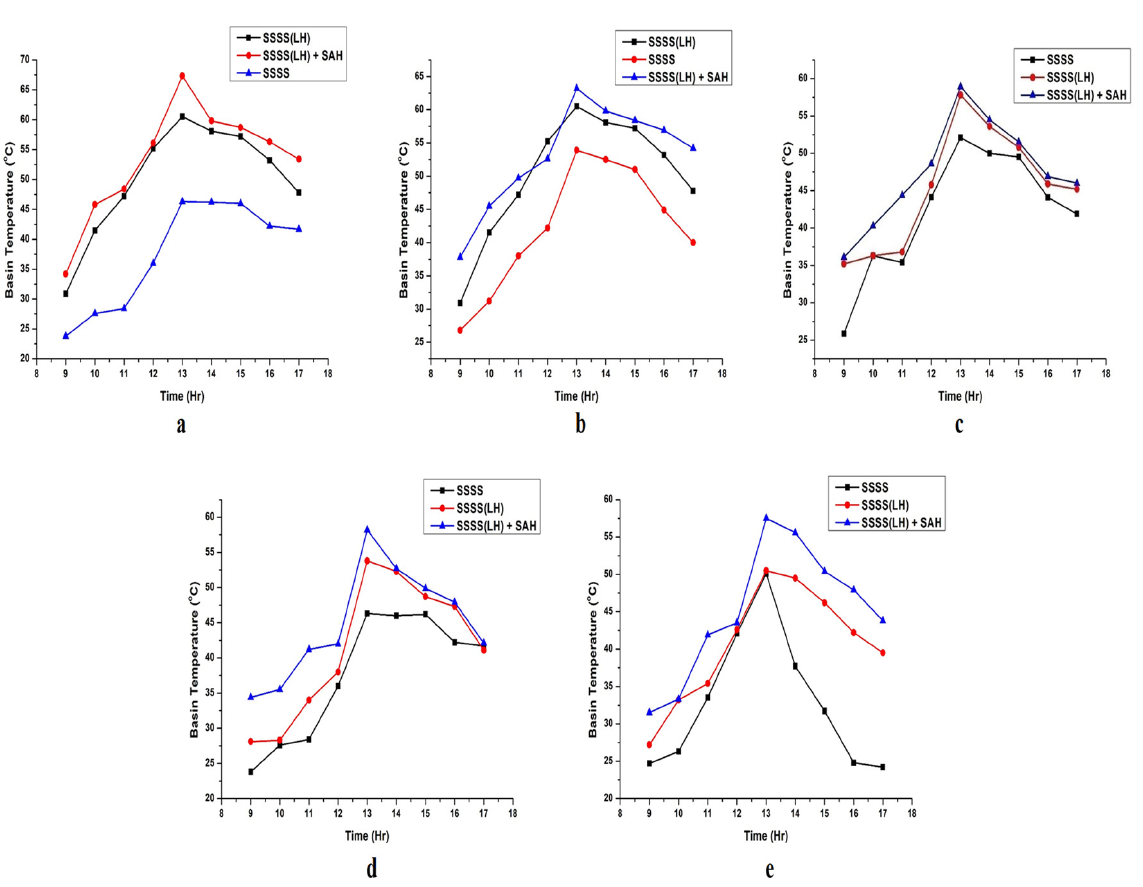
Figure 8. ( a – e ) Variation of basin temperature vs. time at the depth of 3 cm, 6 cm, 9 cm, 12 cm, and 15 cm, respectively. 15 cm,